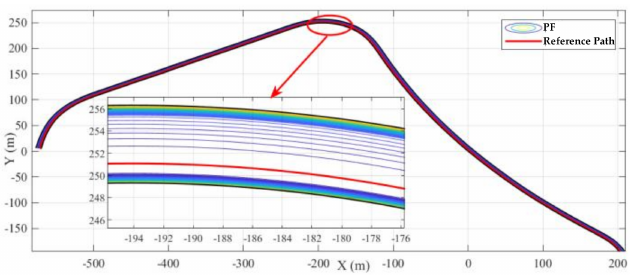
Figure 3. Path generation based on the comprehensive road potential